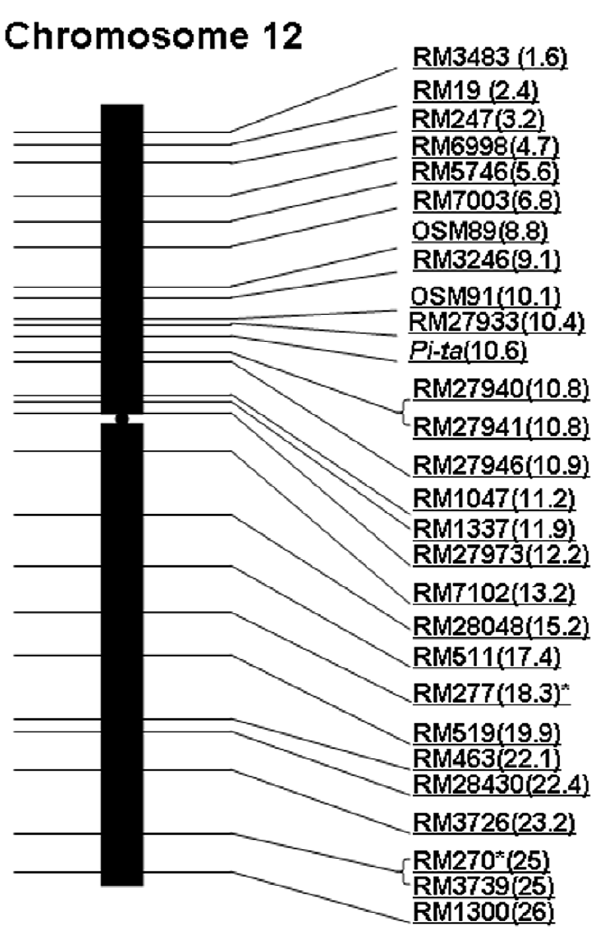
Figure 2. Schematic presentation of chromosome 12 with physical location (MB) of each SSR marker used for this study. Locations of SSR markers were obtained from www.gramene.org. *Physical location unavailable in gramene thus was determined by blasting the primers to the Nipponbare genome.